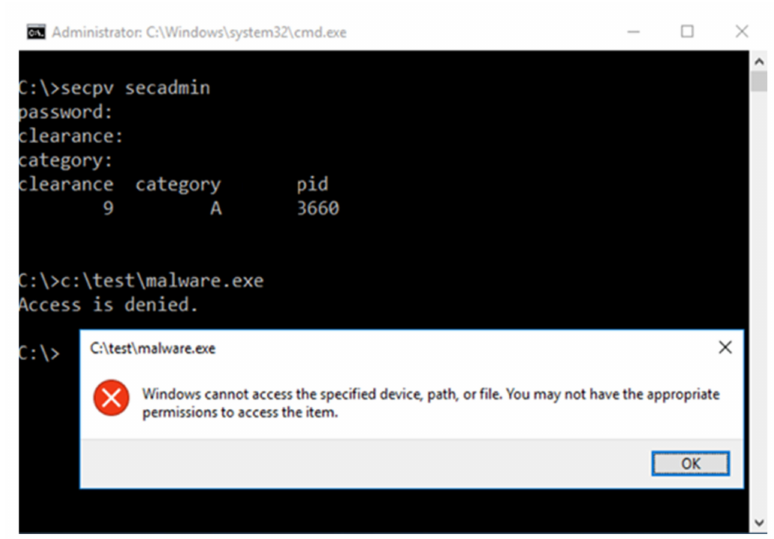
Figure 16. MAC-based whitelist security system execution